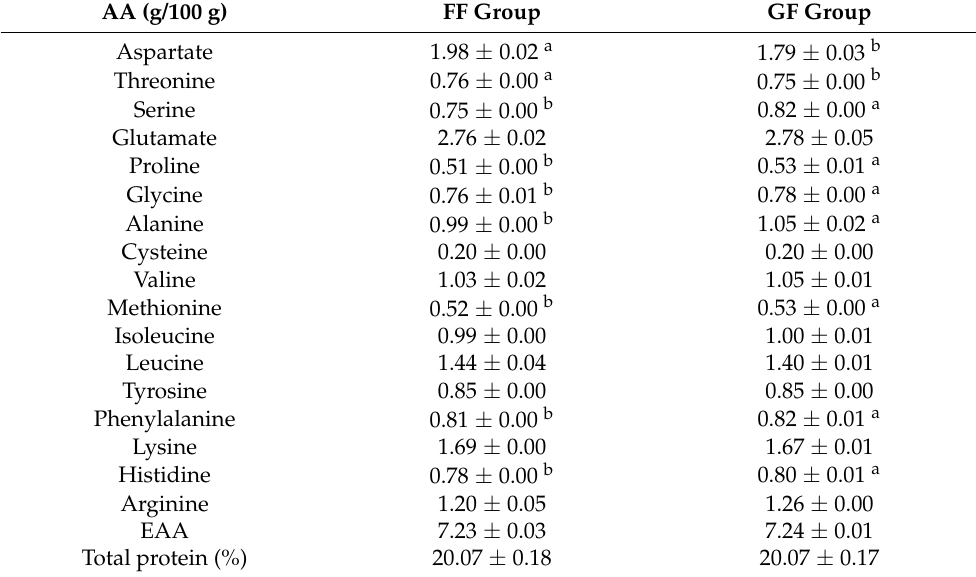
Table 3. Amino acid composition of LTL(longissimus thoracis et lumborum ) under different rearing conditions in Heigai